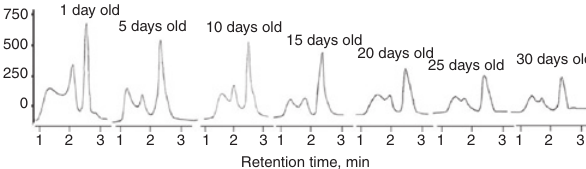
Figure 4: HPLC chromatograms of pteridines extracted from whole body of adult Anopheles stephensi of different age